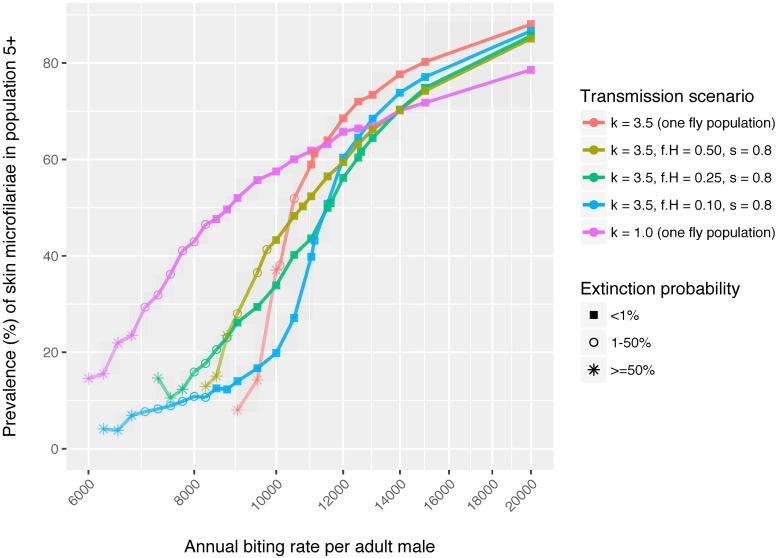
Model-predicted association between annual biting rate, prevalence of skin microfilariae, and stability of transmission.Bullets represent the average skin mf prevalence over 150 repeated simulations, with the shape of the bullet indicating the extinction probability (here defined as the proportion of repeated simulations in which transmission spontaneously faded out within 200 years). The red and purple lines (with k = 3.5 or 1.0 and one fly population) represent transmission scenarios with homogeneous mixing; the other coloured lines represent transmission scenarios with assortative mixing, assuming presence of two fly populations where some proportion fH of the human population with relative high exposure to flies has most of its contact with the fly population H. Parameter s represents the level of segregation of the two fly populations, e.g. s = 0 represents homogeneous mixing (presence of two populations but all humans have equal opportunity to be exposed to both) and s = 1 represents two completely segregated fly populations for which the biting affects two completely segregated human populations. See Methods section for details.